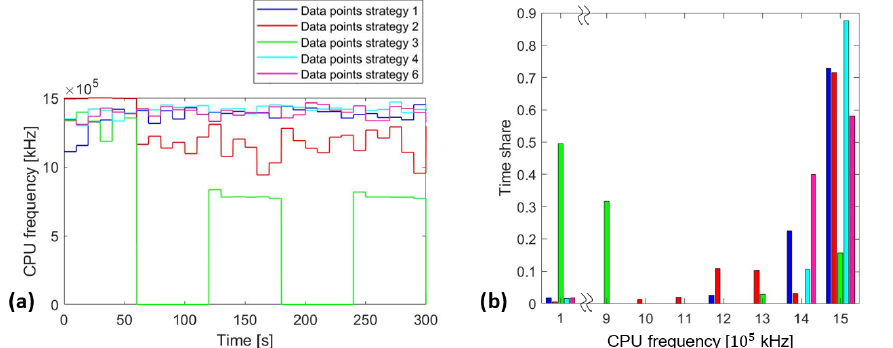
Figure 9. Timeline (a) and bar plot (b) of CPU frequencies of different strategies.